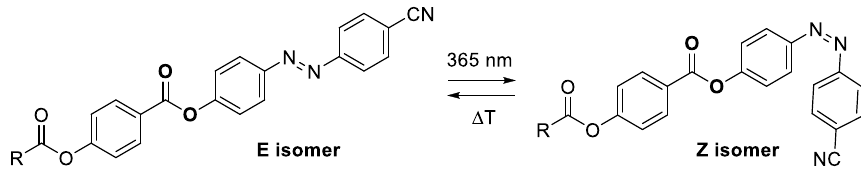
Figure 4. UV-light induced E - to Z -isomerization of the prepared materials IIa,b .